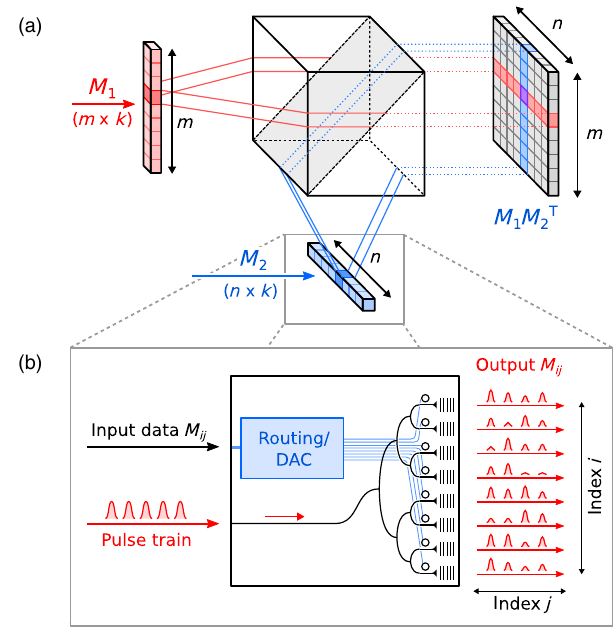
FIG. 6. (a) Matrix multiplication with a 2D detector array, two 1D transmitter arrays, and optical fan-out. Imaging lenses (including cylindrical lenses for row and column fan-out) not shown. (b) Schematic diagram of transmitter array.